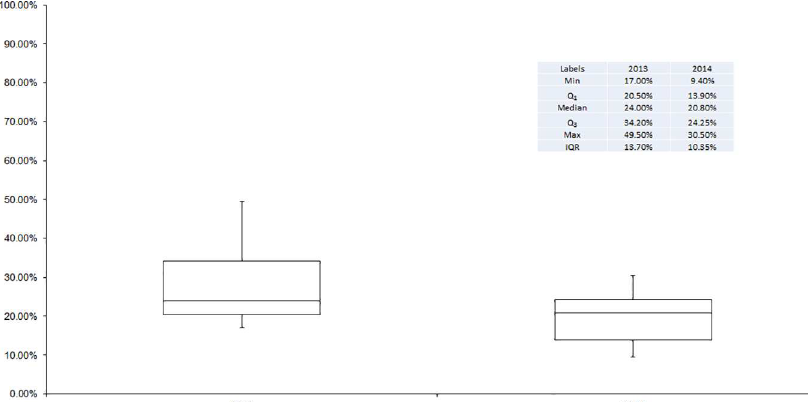
Fig 3. Box plots of the percentage of eligible women receiving Misoprostol in each LGA by